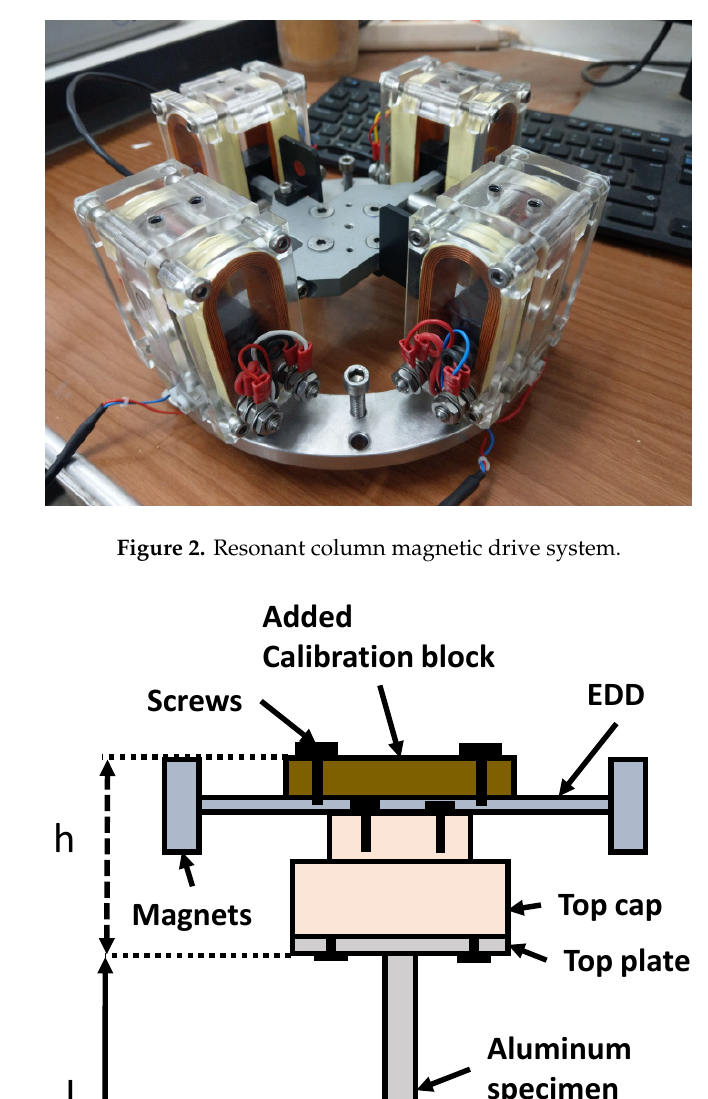
Figure 2. Resonant column magnetic drive system.